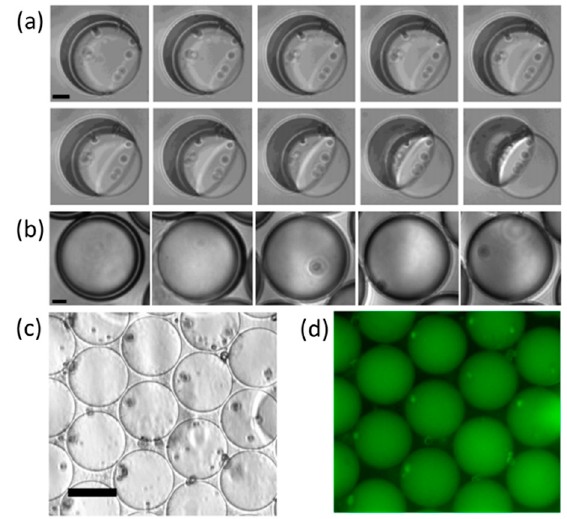
Figure 14. ( a ) Bright-field microscope images of a PEG(5000)-b-PLA(5000) polymersome